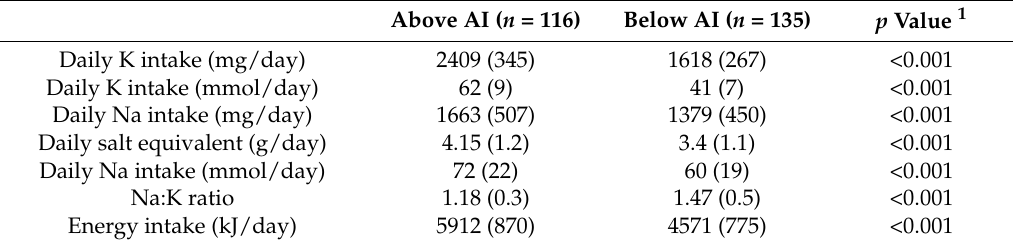
Table 2. Descriptive characteristics for sodium (Na), potassium (K), and energy intakes for the two groups of children above and below the recommended adequate intake (AI) of 2000 mg/day for potassium for children aged 1–3 years [15] (mean (SD)). Above AI ( n =